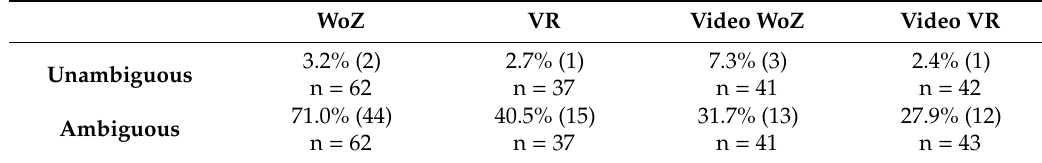
Table 3. Misinterpretations of the intention AV goes first